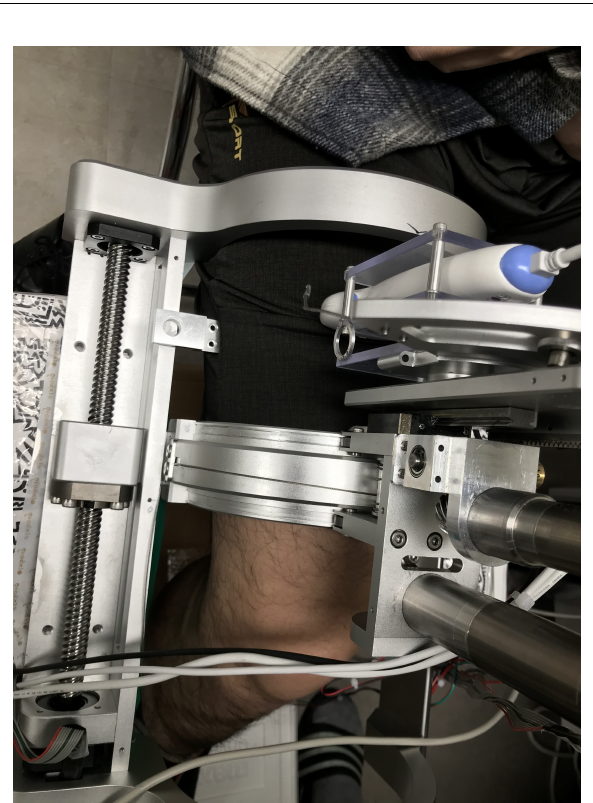
Figure 12. Stiffness test